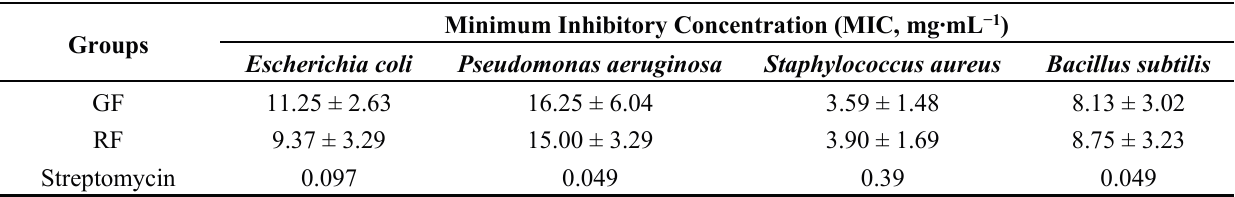
Table 2. Minimum inhibitory concentration (MIC) of GF and RF against four bacterial strains (mean ± SD, n =